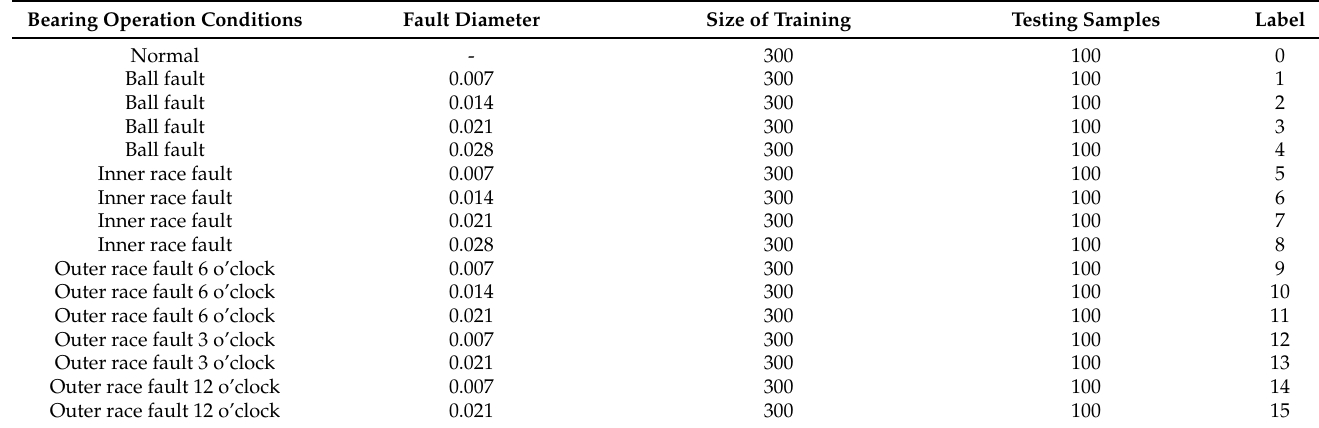
Table 1. Description of the bearing operation conditions.